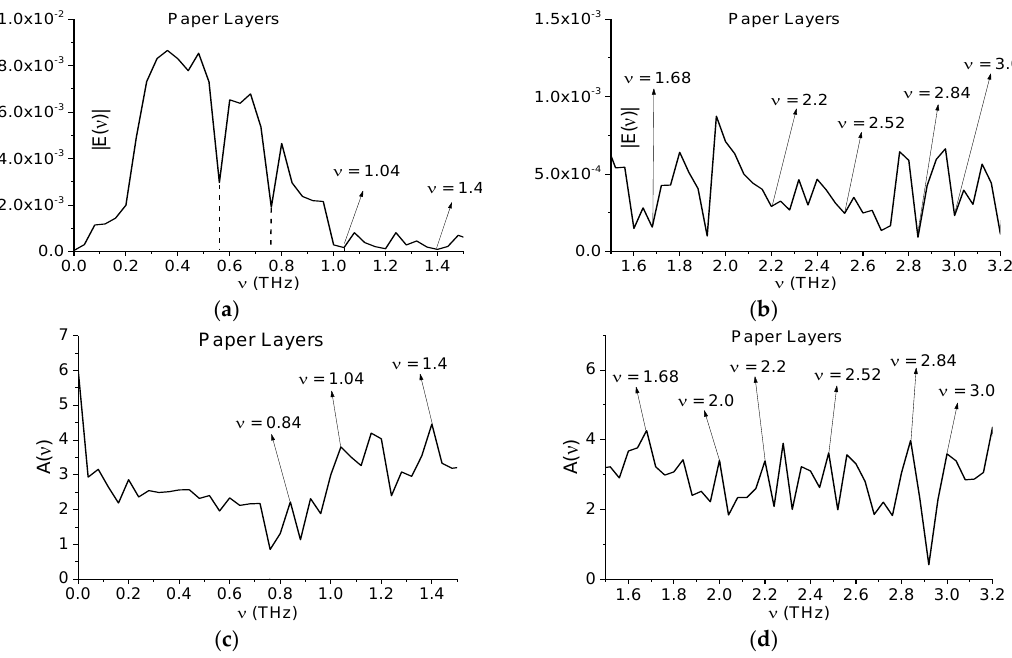
Figure 3. Fourier spectrum ( a , b ) and absorbance ( c , d ) of the main pulse for the signal Paper Layers in the frequency range ν = [0, 1.5] THz ( a,c ); [1.5, 3.2] THz ( b,d ) [29].